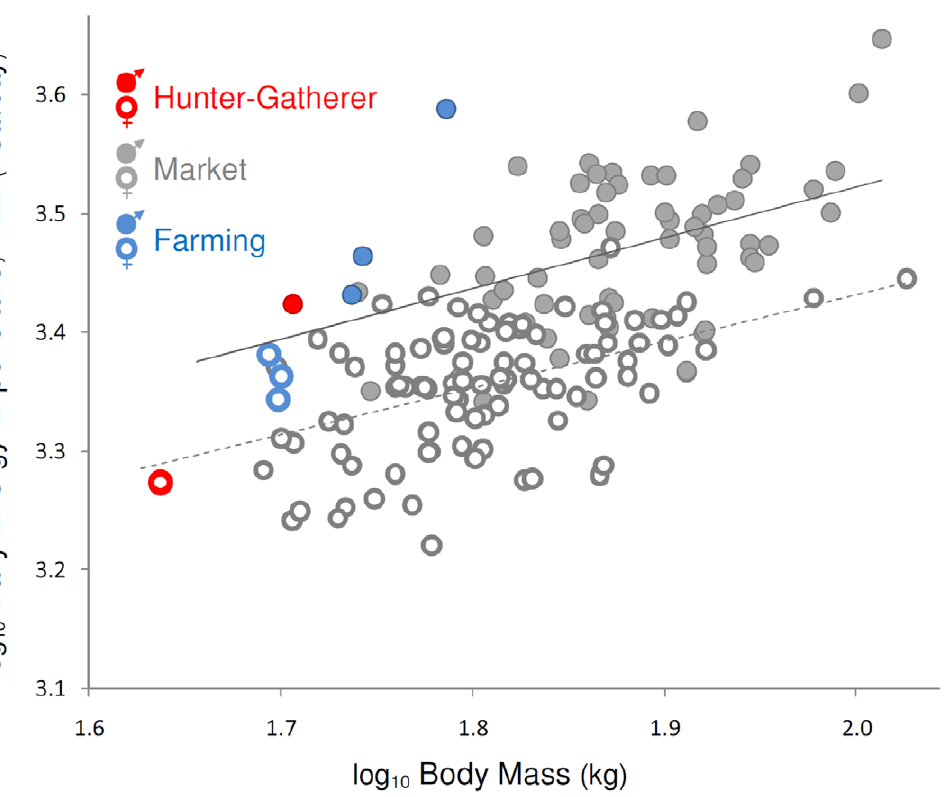
Figure 2. Population comparisons of TEE. Energy expenditure among Hadza hunter-gatherers (red circles) was similar to populations in market economies; subsistence farming populations (Nigeria, Gambia, Bolivia; blue circles) had higher TEE than other groups. All non-Hadza data from [16] (Text S1). Each symbol is a single-sex population mean; male and female means are plotted separately for mixed-sex studies. Ordinary least squares regression lines are shown for all men (filled circles, solid line) and all women (open circles, dashed line). When controlling for body mass, men had higher TEE than women (F(162)=86.75, p , 0.001).